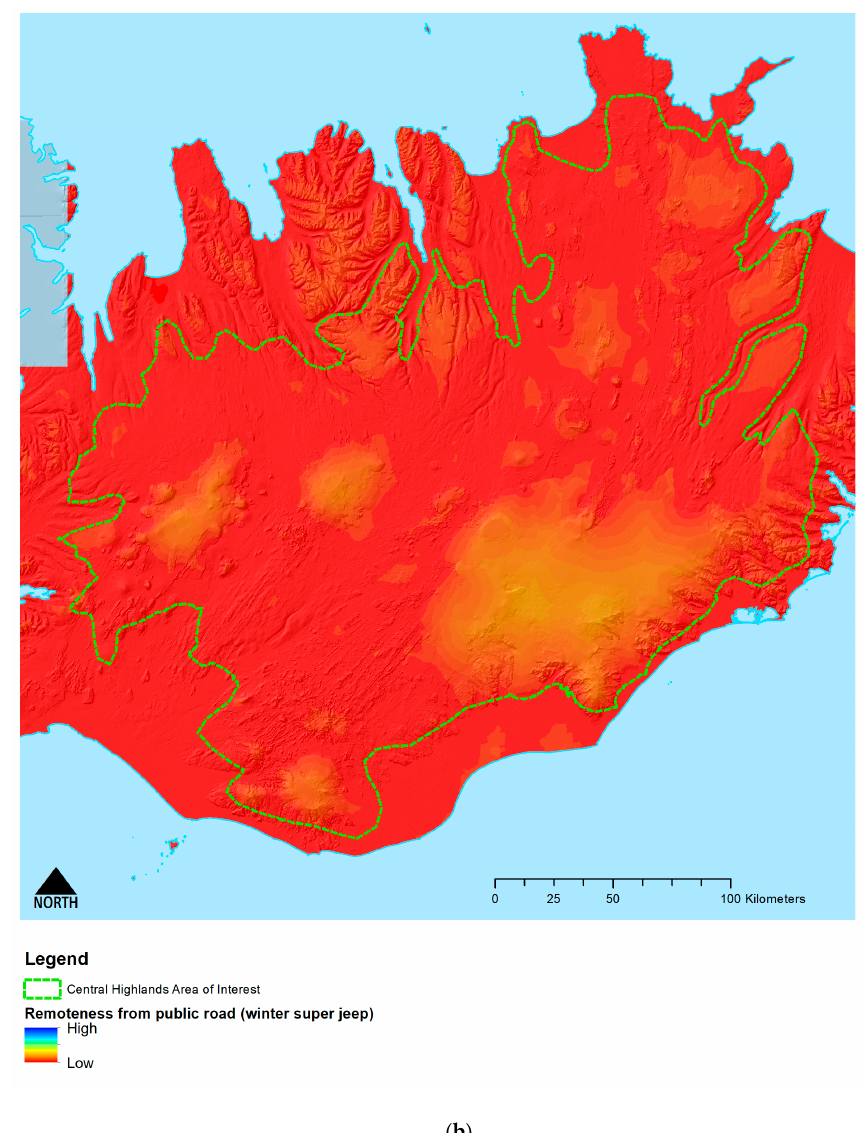
Figure 3. Summer ( a ) and winter ( b ) remoteness surface.